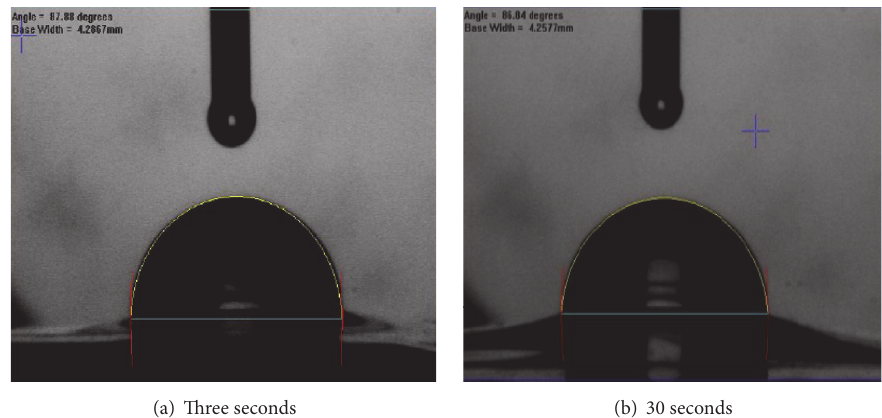
Figure 8: Water drops into the NM-1H membrane; after 30secs, the membrane was swollen and caused a projection phenomenon.